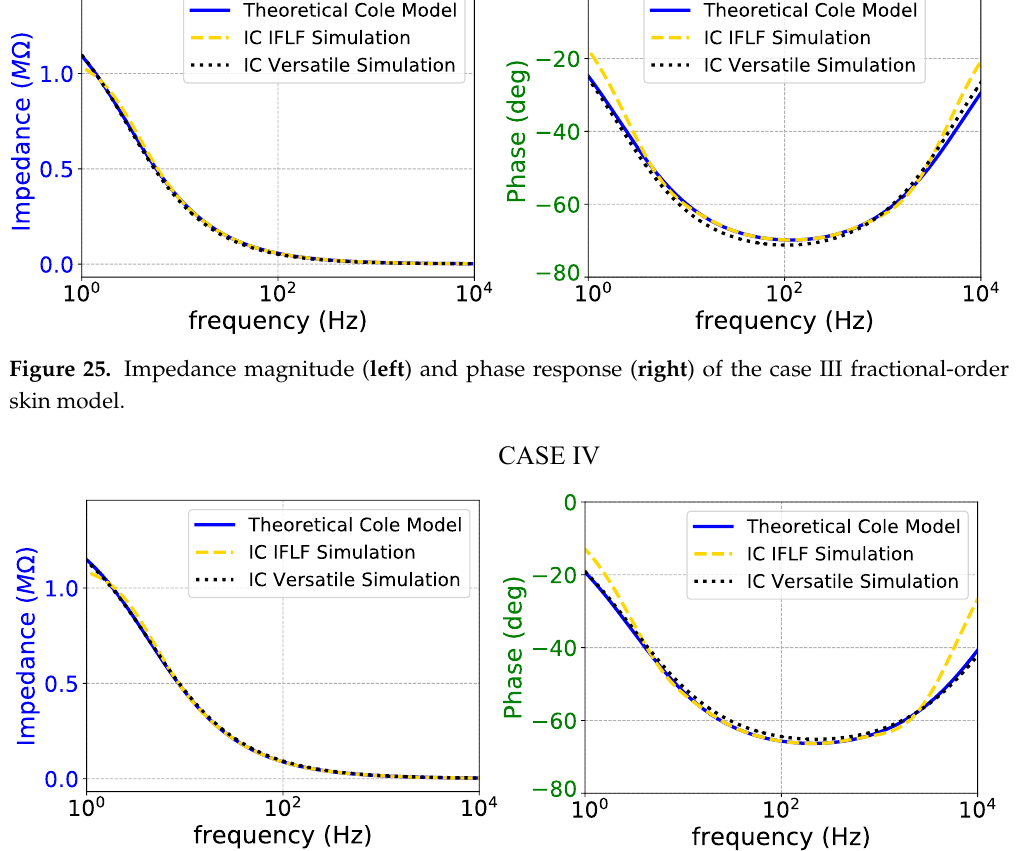
Figure 26. Impedance magnitude ( left ) and phase response ( right ) of the case IV fractional-order skin